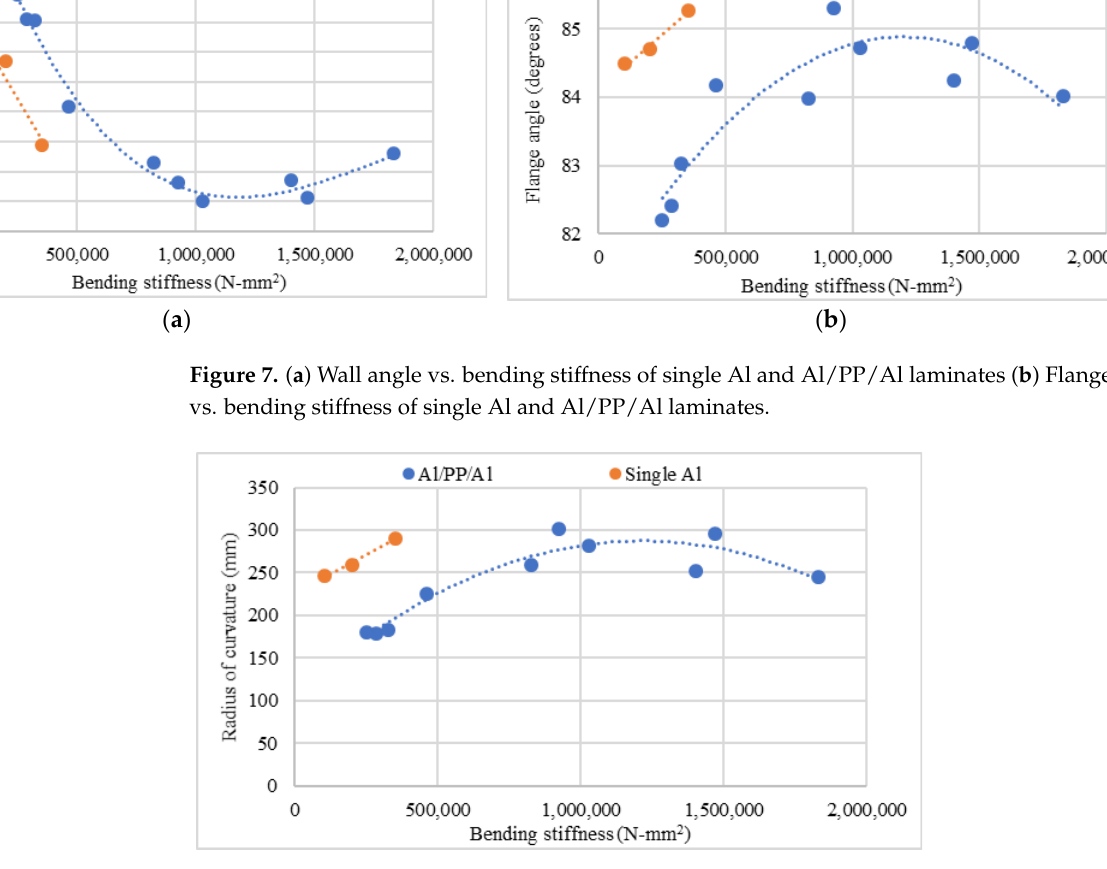
Figure 8. Radius of curvature vs. bending stiffness of single Al and Al/PP/Al laminates. Table 6. Comparison of springback angles and radius of curvature of U-channels of a single aluminum sheet and two Al/PP/Al sandwich